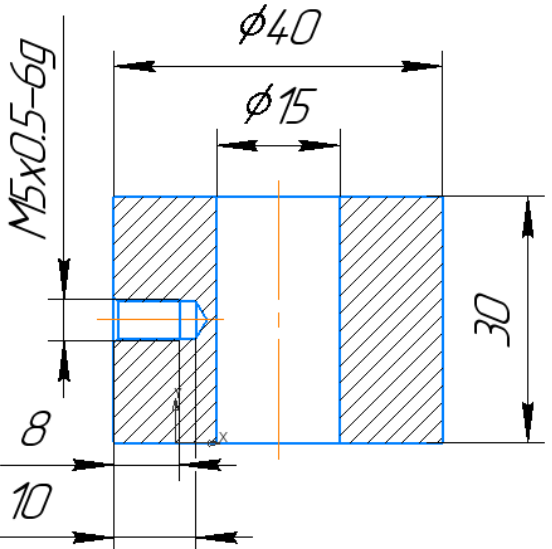
Figure 5. Ring-shaped electrode tools.